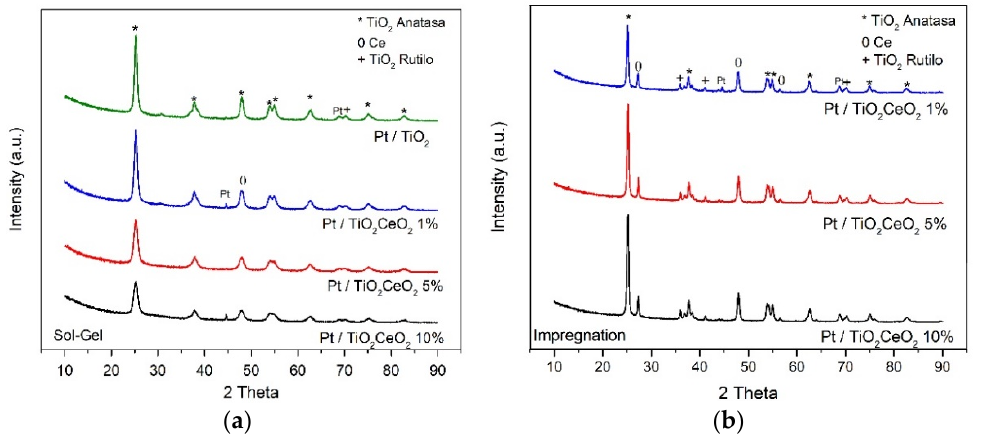
Figure 1. XRD of the catalysts Pt/TiO 2 and Pt/TiO 2 -CeO 2 : ( a ) Sol-gel and ( b ) Impregnation.